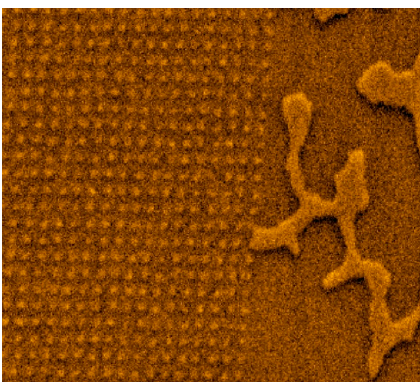
Figure 6. The MFM image of the Co/Pt film locally irradiated by focused He + ion beam. The irradiated area is on the left side, unirradiated area is on the right side of the picture. The MFM frame size is 5 μ m × 5 μ m. The MFM contrast is normalized to the maximum.